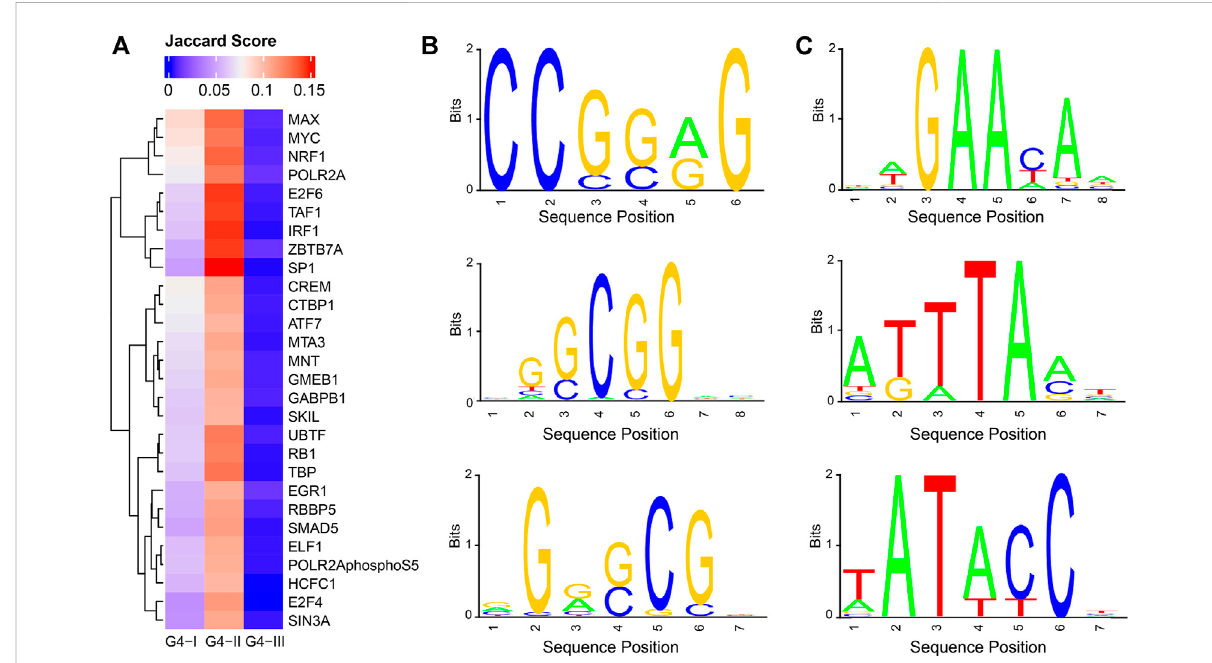
FIGURE 7 PotentialcooperationbetweenG4groupsandTFsaswellasnovelconsensussequencesidenti fi edinG4feet. (A) Jaccardscorestoevaluatethe overlapping ratios between binding sites of TFs and G4 groups. 28 TF s were selected with Jaccard scores larger than 0.1 for at least one of three G4 groups. (B) Three selected sequence logos enriched in G4-II feet. (C) Three selected sequence logos identi fi ed for G4-III